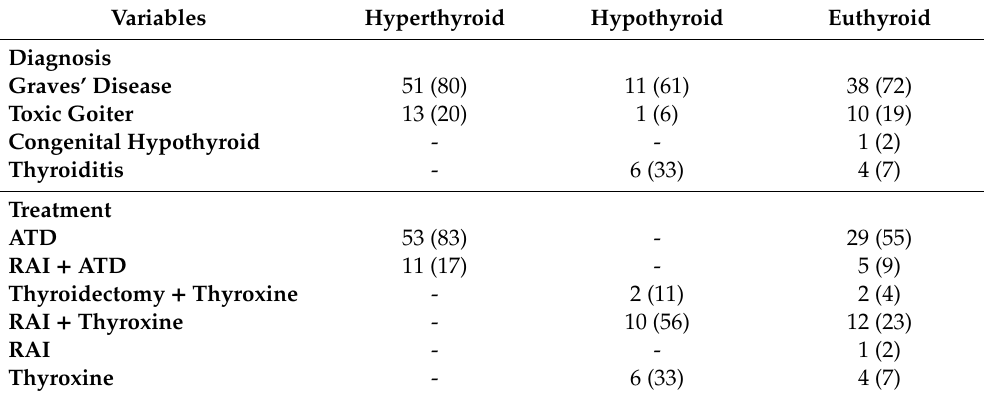
Table 2. Diagnosis and Treatment According to Groups.